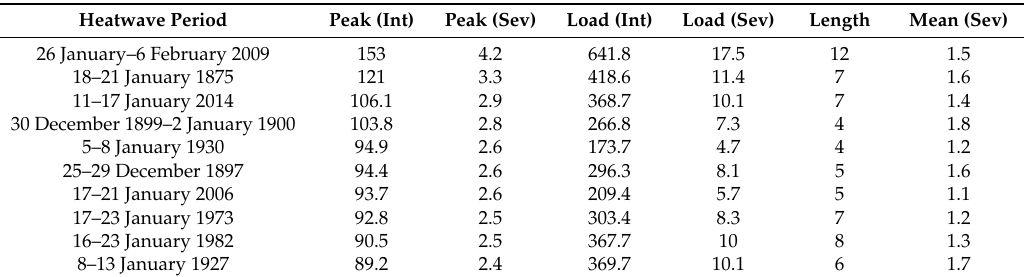
Table 2. Adelaide heatwave event peak, load, length and mean, using intensity and severity (1887 to 2018). Top 10 ranked for event peak. Peak and Load Intensity in units of [°C 2 ]. Peak, Load and Mean Severity are dimensionless [] and Length in days.